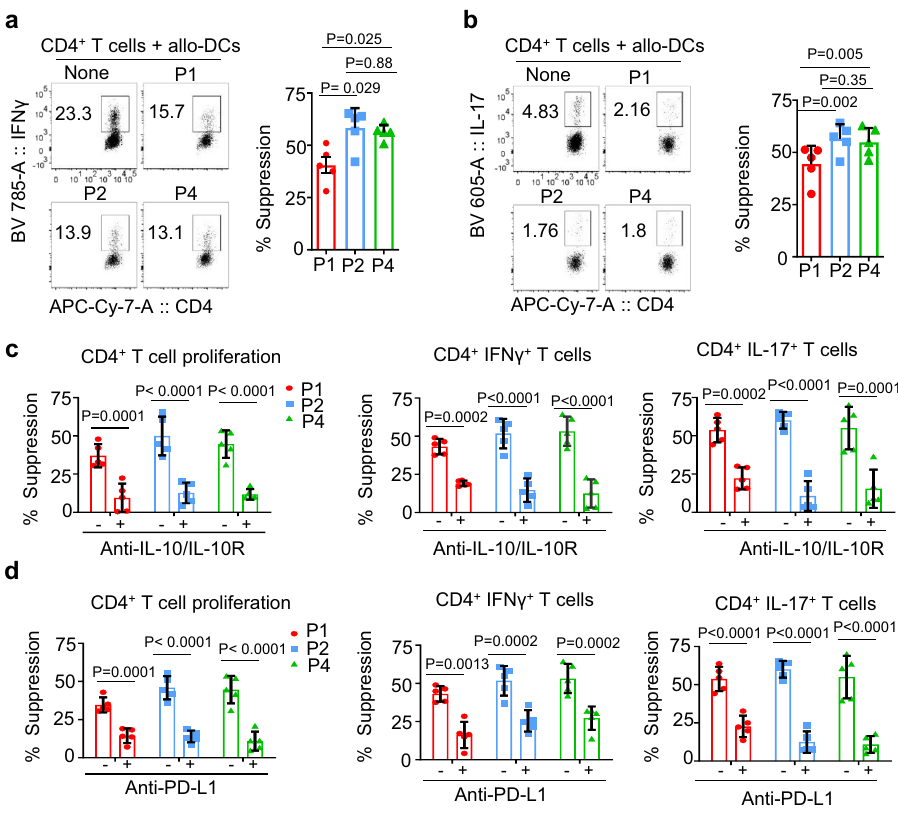
Fig. 4 P2 and P4 B cells are more ef fi cient than P1 B cells at suppressing allogeneic CD4 + T cell response elicited by allogeneic dendritic cells. FACS- sorted P1, P2, and P4 B cells from the blood of healthy subjects were stimulated for 48 h with CpG-B and then cocultured for 6 days with